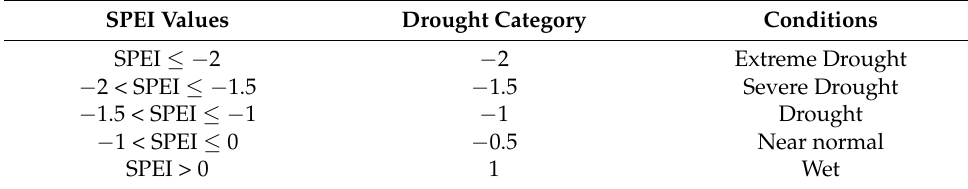
Table 2. Drought categories for the study of drought events. SPEI Values Drought Category